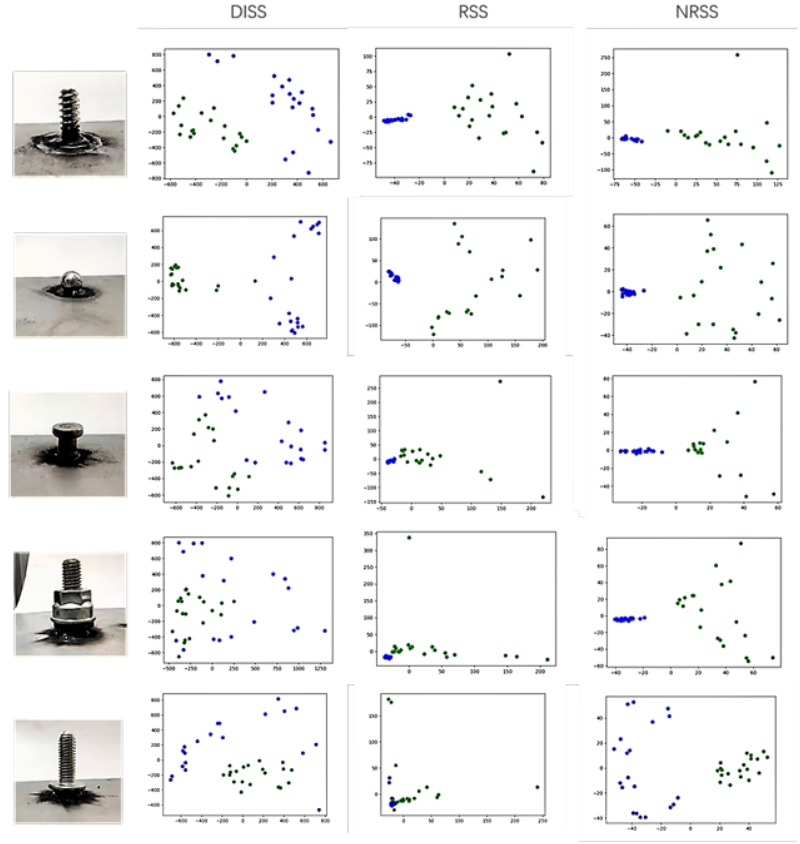
Figure 6. Principal component analysis of extracted features from two inputs.